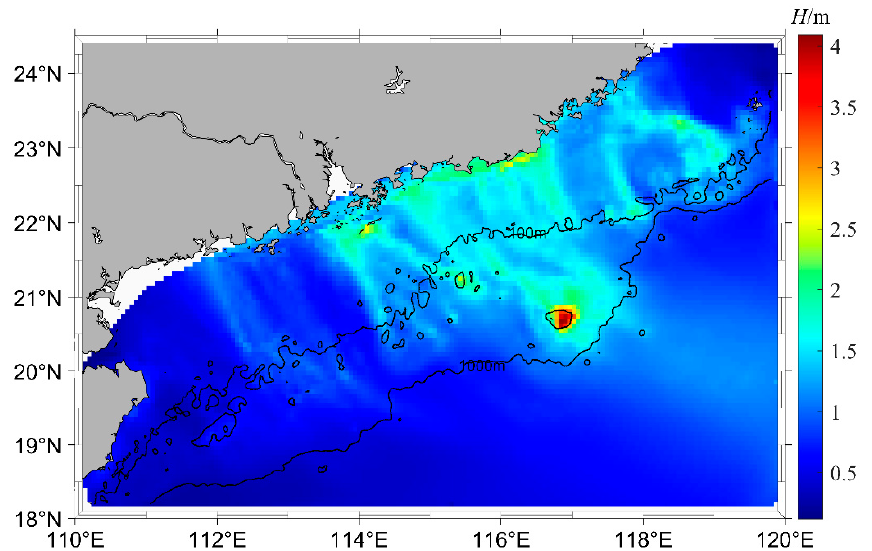
Figure 6. The spatial distribution of wave height ( H ) along the southeast coast of China when return period T r = 200a. The isobaths of 100 m and 1000 m are marked in the figure.